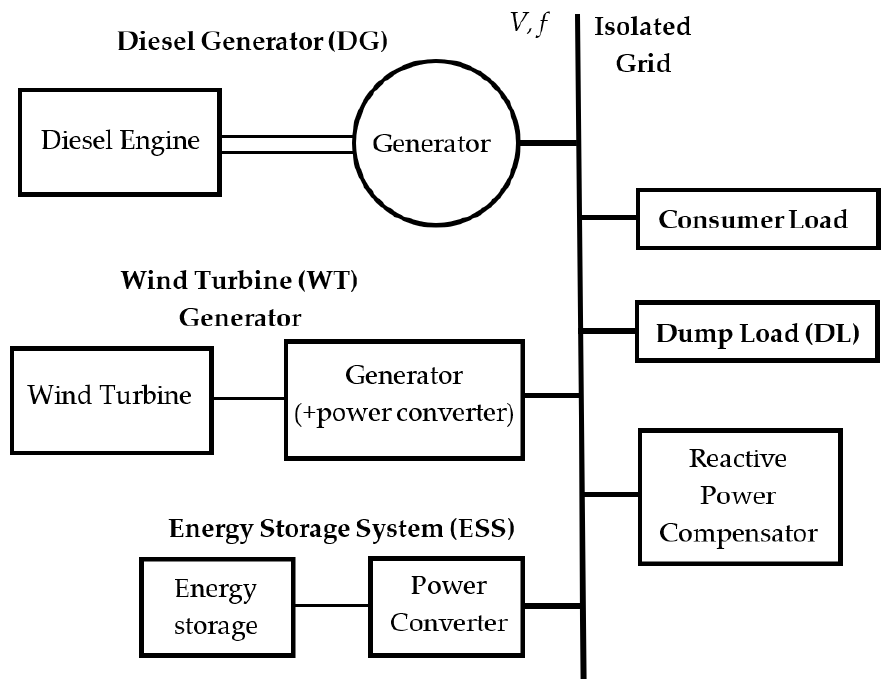
Figure 2. WDHS structure sample. Adapted from Ref. [75].